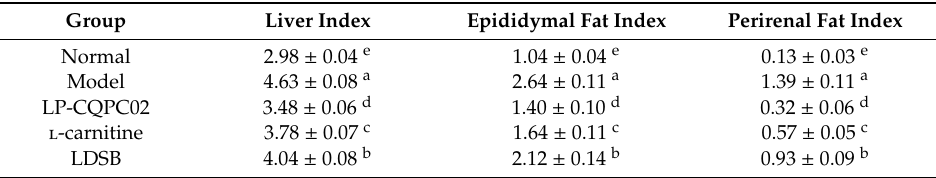
Table 4. Organ index of mice in each group ( n = 10).